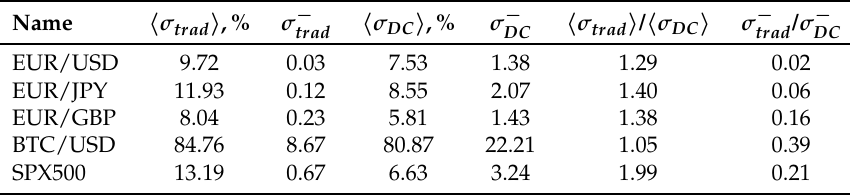
Table 2. Volatility of the considered time series computed using the “traditional” (Equation (20)) and the directional-change (Equation (19)) approaches. Provided values the average of four measurements performed with specific parameters: in the “traditional” case time intervals between observations S n and S n and ∆ t 4 = 1 day. In the case of the directional-change intrinsic time approach, the thresholds δ are δ ( ∆ t 1 ) = 0.013%, δ ( ∆ t 2 ) = 0.039%, δ ( ∆ t 3 ) = 0.095%, δ ( ∆ t 4 ) = 0.458% (FX prices), δ ( ∆ t 1 ) = 0.09%, δ ( ∆ t 2 ) = 0.33%, δ ( ∆ t 3 ) = 0.89%, δ ( ∆ t 4 ) = 5.13% (BTC prices), and δ ( ∆ t 1 ) = 0.006%, δ ( ∆ t 2 ) =